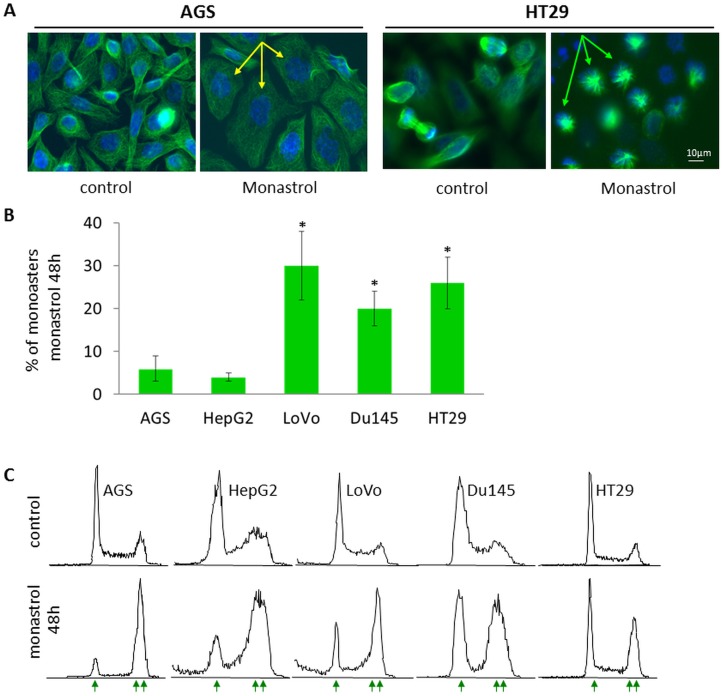
Microtubule cytoskeleton and cell morphology, and cell-cycle distribution following 48h treatment with monastrol.(A) AGS and HT29 cells were treated for 48h with 100μM and 150μM of monastrol, respectively. Tubulin cytoskeleton was visualized following fixation by immunostaining, DNA was stained with DAPI. Following 48h of monastrol treatment, the majority of AGS cells appeared as large, G1-like cells with one nucleus (yellow arrows), while a high percentage of HT29 cells were arrested in mitosis as monoasters (green arrows). (B) Effect of prolonged treatment with monastrol on percentage of monoasters in the different cell-lines, indicated at the bottom. Cells were treated with monastrol, processed for immunostaining, and the percentage of monoasters was determined by scoring 200–300 cells for each cell-line. Columns and bars represent averages and SEM of 3 independent experiments, *P<0.05, compared to AGS cells. (C) Distribution of cell-cycle phases was determined by flow cytometry in the absence (control) or presence of monastrol. Cell-lines are indicated on top. Single and double arrows represent peaks with 2n and 4n DNA content, respectively.